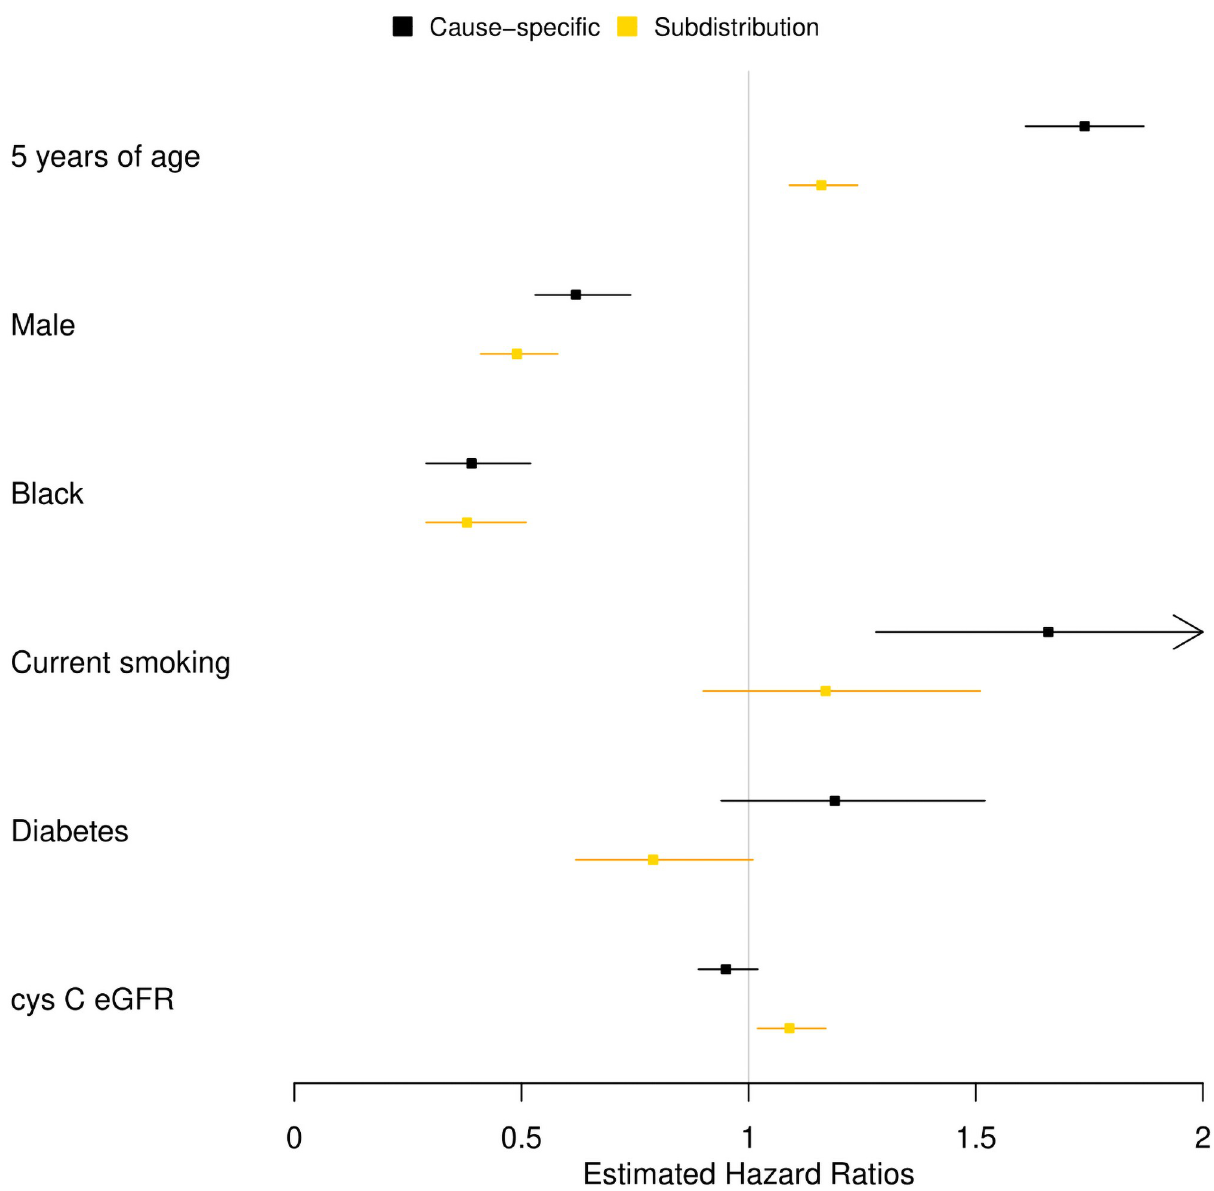
Fig 2. Hazard ratios estimates. Contrasting the magnitudes of the hazard ratio estimates for incident hip fracture between the cause-specific and FG subdistribution